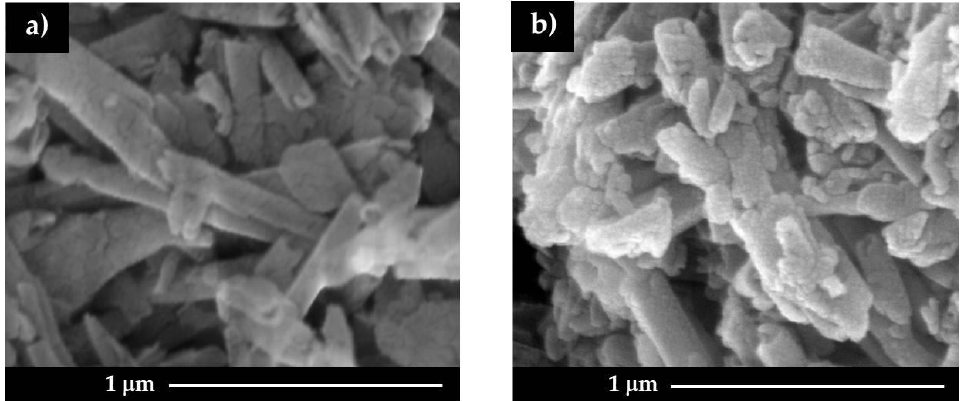
Figure 1. SEM images for HNT/khellin ( a ) and HNT/khellin coated with chitosan in NaCl solution ( b ).